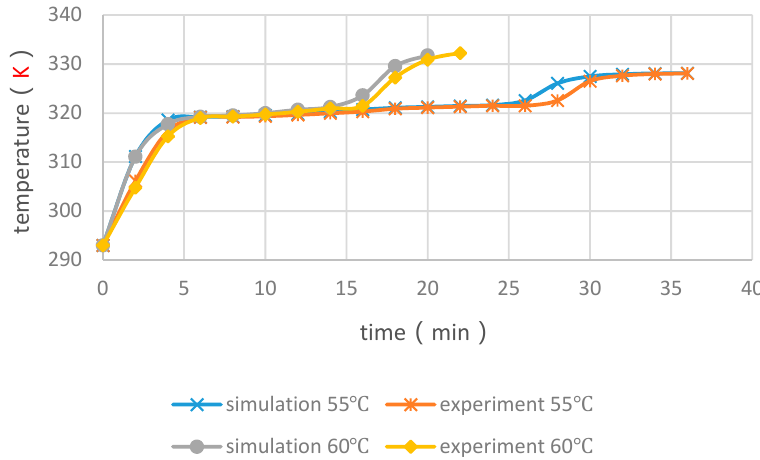
Figure 8. Experimental and numerical results of middle temperatures of PCM cylinder modules when the diameter is 20 mm.